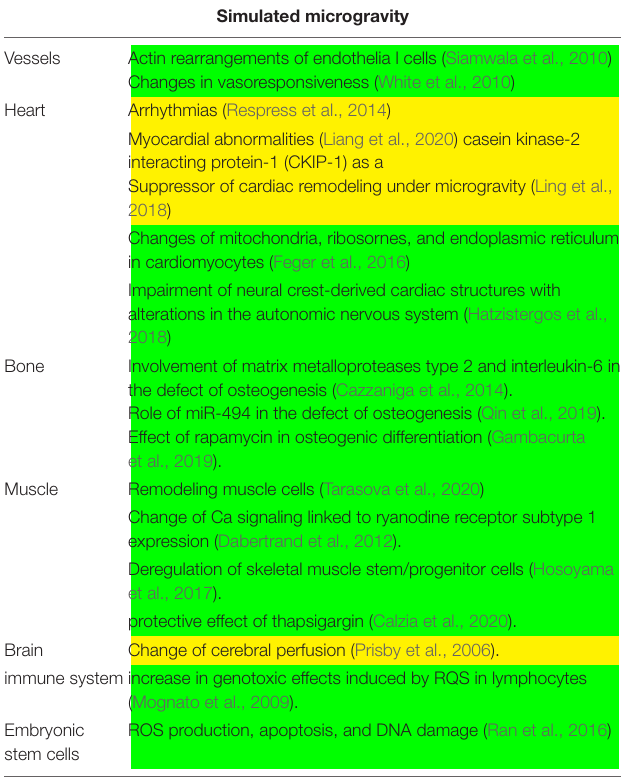
TABLE 2 | Main experiments conducted in simulated microgravity. In yellow, in vivo experiments; in green, in vitro experiments. Simulated